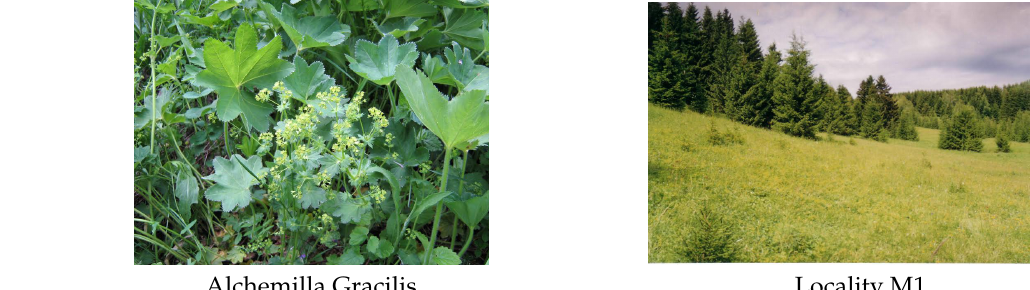
Figure 10. Alchemilla Gracilis plant ( left ) and its habitat ( right